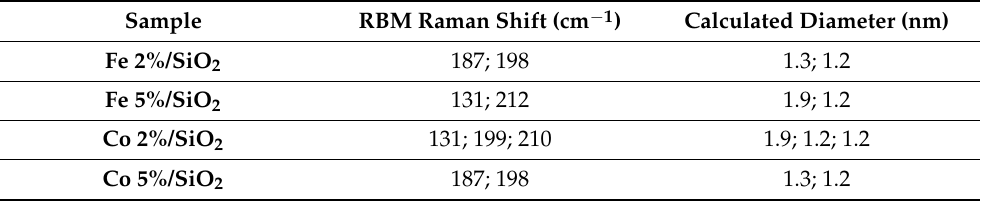
Table 5. Calculation of nanotube diameter from RBM mode Raman